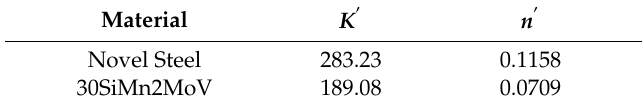
Figure 6. Cyclic stress amplitude versus plastic strain amplitude of the novel steel and 30SiMn2MoV steel at 700 °C. Table 3. The cyclic stress–strain parameters of the novel steel and 30SiMn2MoV steel.